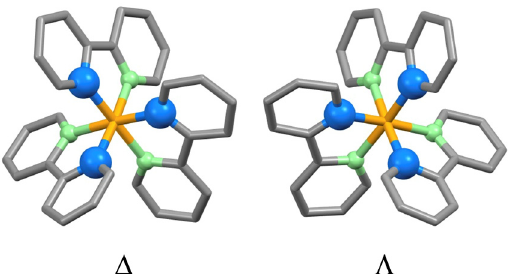
Figure 2. The absolute configuration of the enantiomers of an [M(bpy) 3 ] coordination moiety is conveniently denoted by the stereochemical descriptors Δ and Λ . In each bpy ligand, the green atoms are further away from the observer and the blue atoms are closer and can be related to an axis orthogonal to the plane of the paper and running through the metal center. An anti-clockwise rotation of the right-hand structure about this axis will “dig” the propeller into the page and this is described as the Λ -enantiomer. The mirror-image propeller on the left must be rotated clockwise about the axis to screw into the page and is denoted as the Δ -enantiomer.